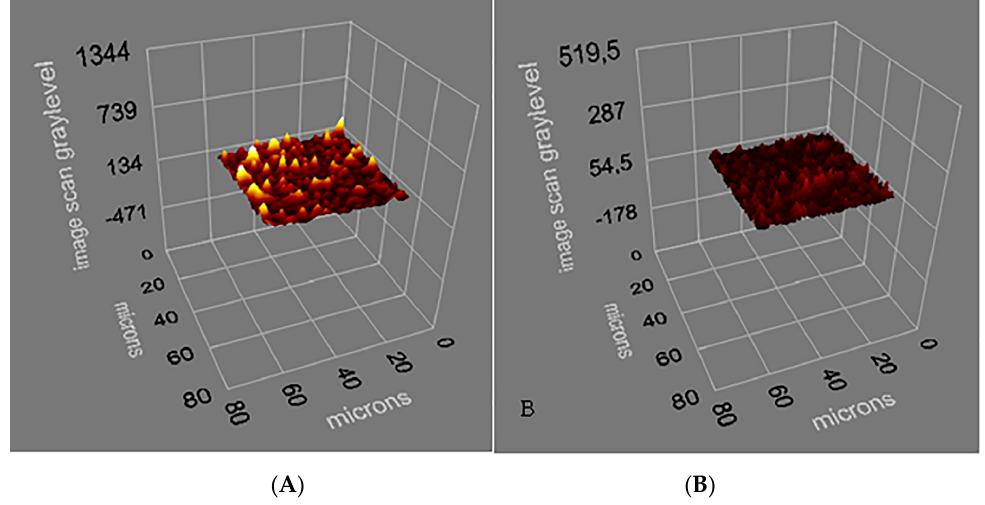
Figure 3. Ellipsometry of ( A ) microcontact S. paratyphi imprinted and ( B ) non-imprinted SPR chip surfaces.